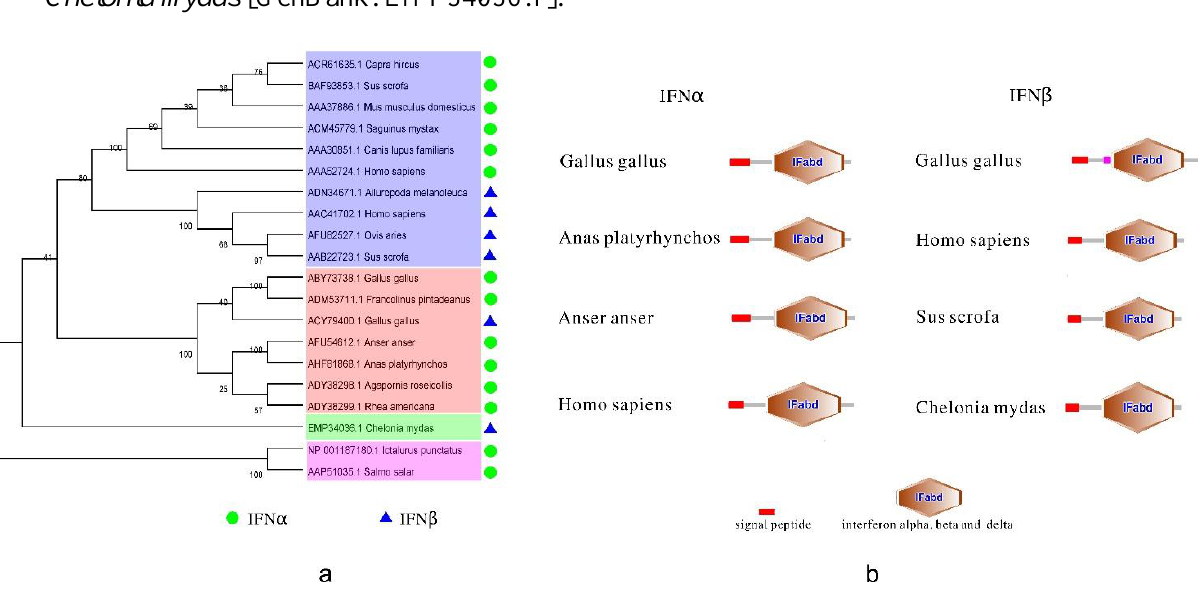
Figure 1. The phylogenetic tree and the protein structure of bird type I interferon (IFN). ( a ) The phylogenetic tree of type I IFN. It was built by MEGA5 program (http://www.megasoftware.net/) with 1000 bootstrap replicates and based on the neighbor-joining method. Blue, orange, green, pink in the picture represent mammals, birds, reptiles and amphibians, fish, respectively; and ( b ) The structure of bird type I